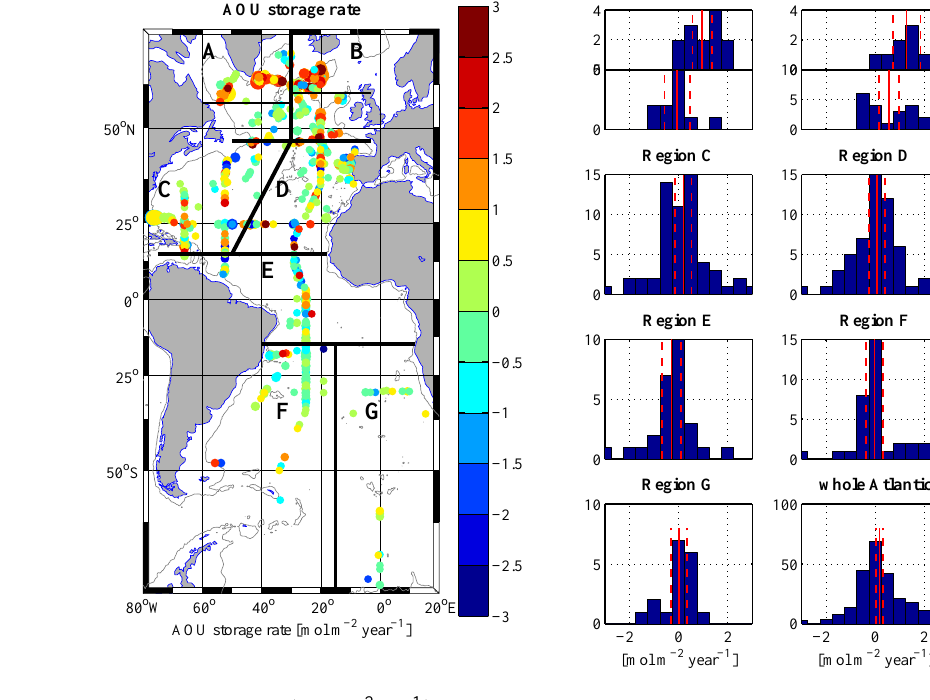
Fig. 5. Same as Fig. 2 but for storage rates (molm − 2 yr − 1 ) of AOU.